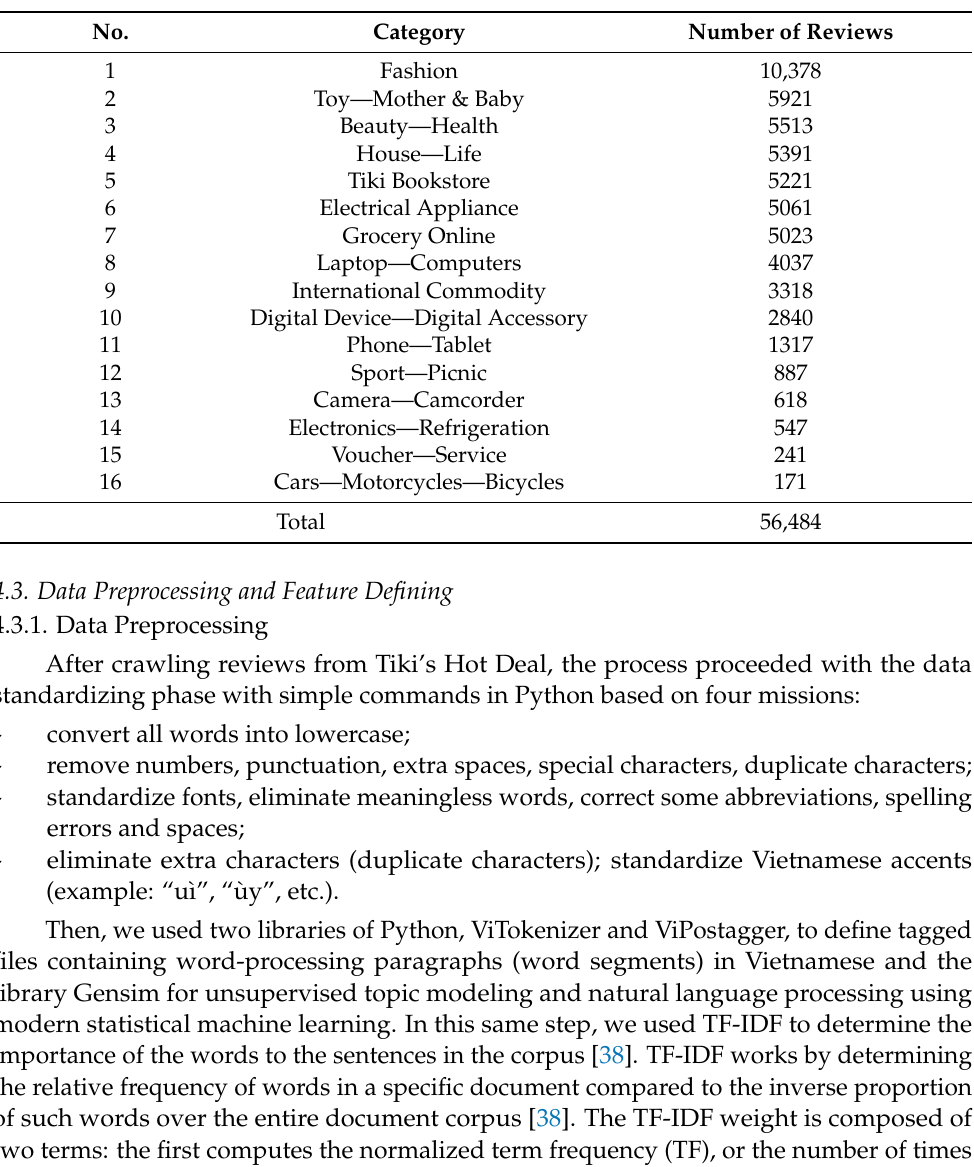
Table 1. Data collected from Hot Deal of